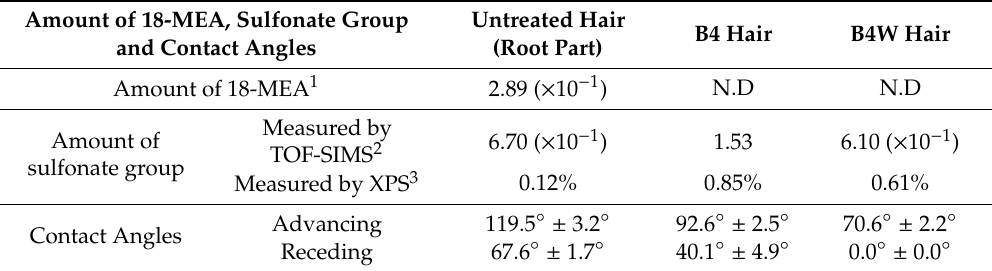
Table 3. Comparison of untreated hair, bleached hair (B4 hair) and bleached and weathered hair (B4W hair).